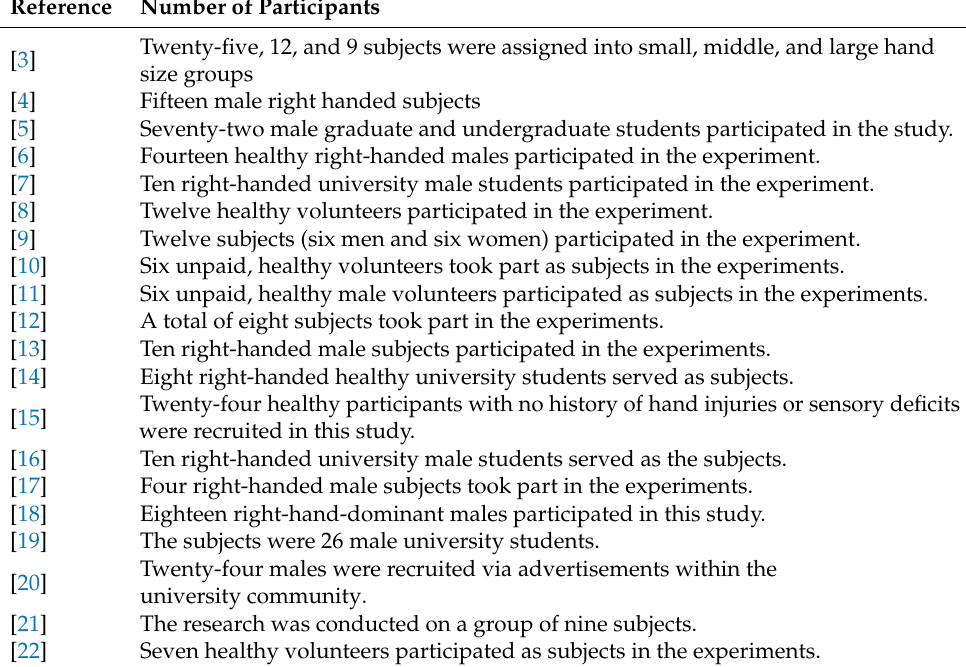
Table 1. Number of subjects in